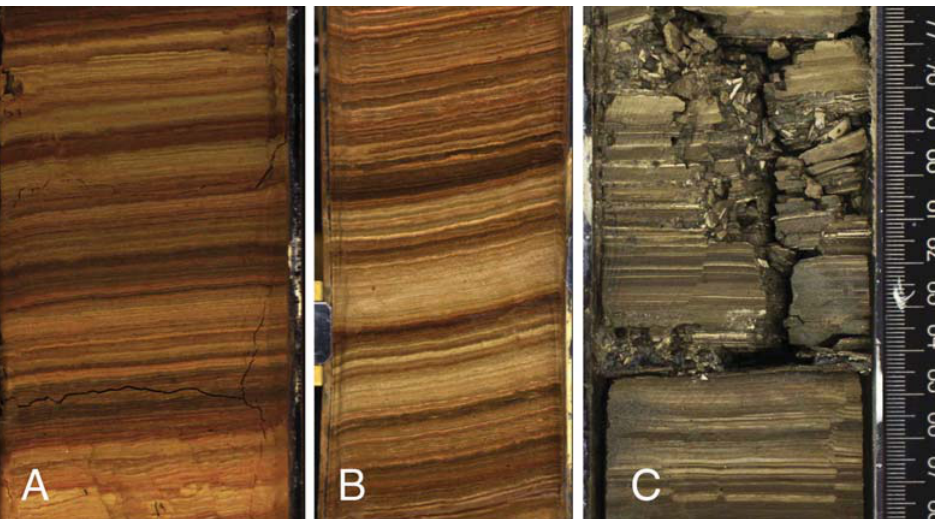
Figure 11. Three examples of finely laminated background deposits from Ahlat Ridge. The example A originates from ~1 m depth and was deposited in the Holocene. Preliminary age data indicates that the example B